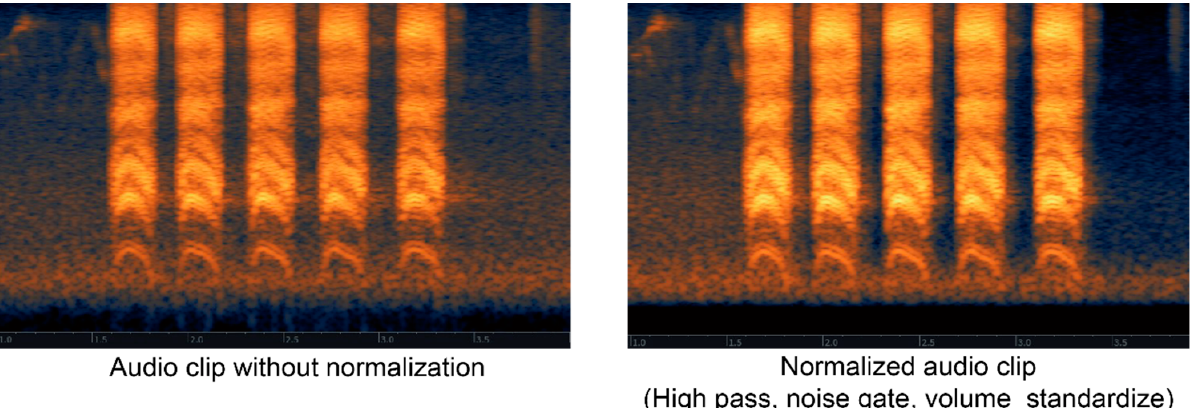
Figure 2. Comparison of the audio clips ( Corvus brachyrhynchos ). High pass filters the redundant low frequencies; noise gate suppresses the background noise; volume standardizer gains the maximum volume to zero decibels.